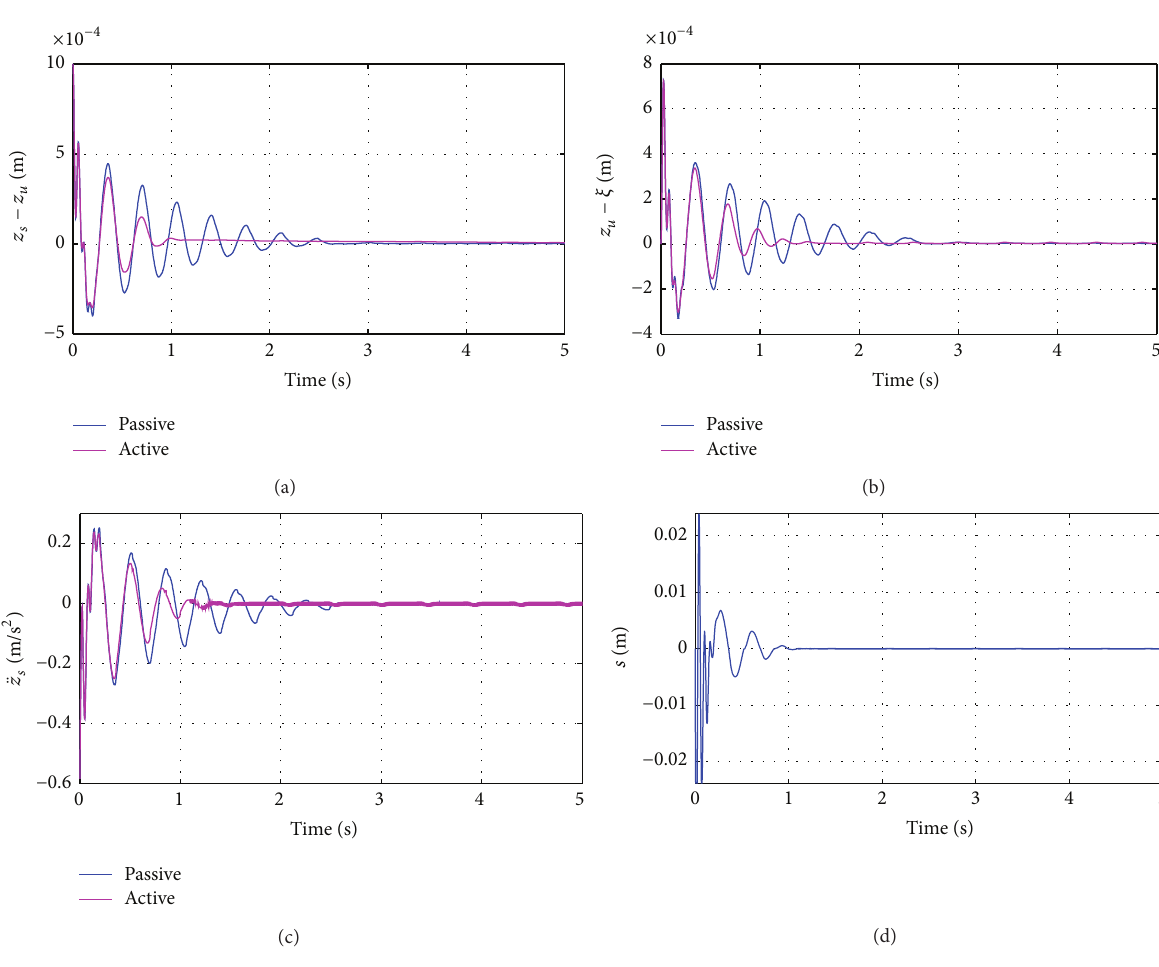
Figure 3: No road profile: (a) suspension deflection, (b) tire deflection, (c) sprung mass acceleration, and (d) sliding surface.